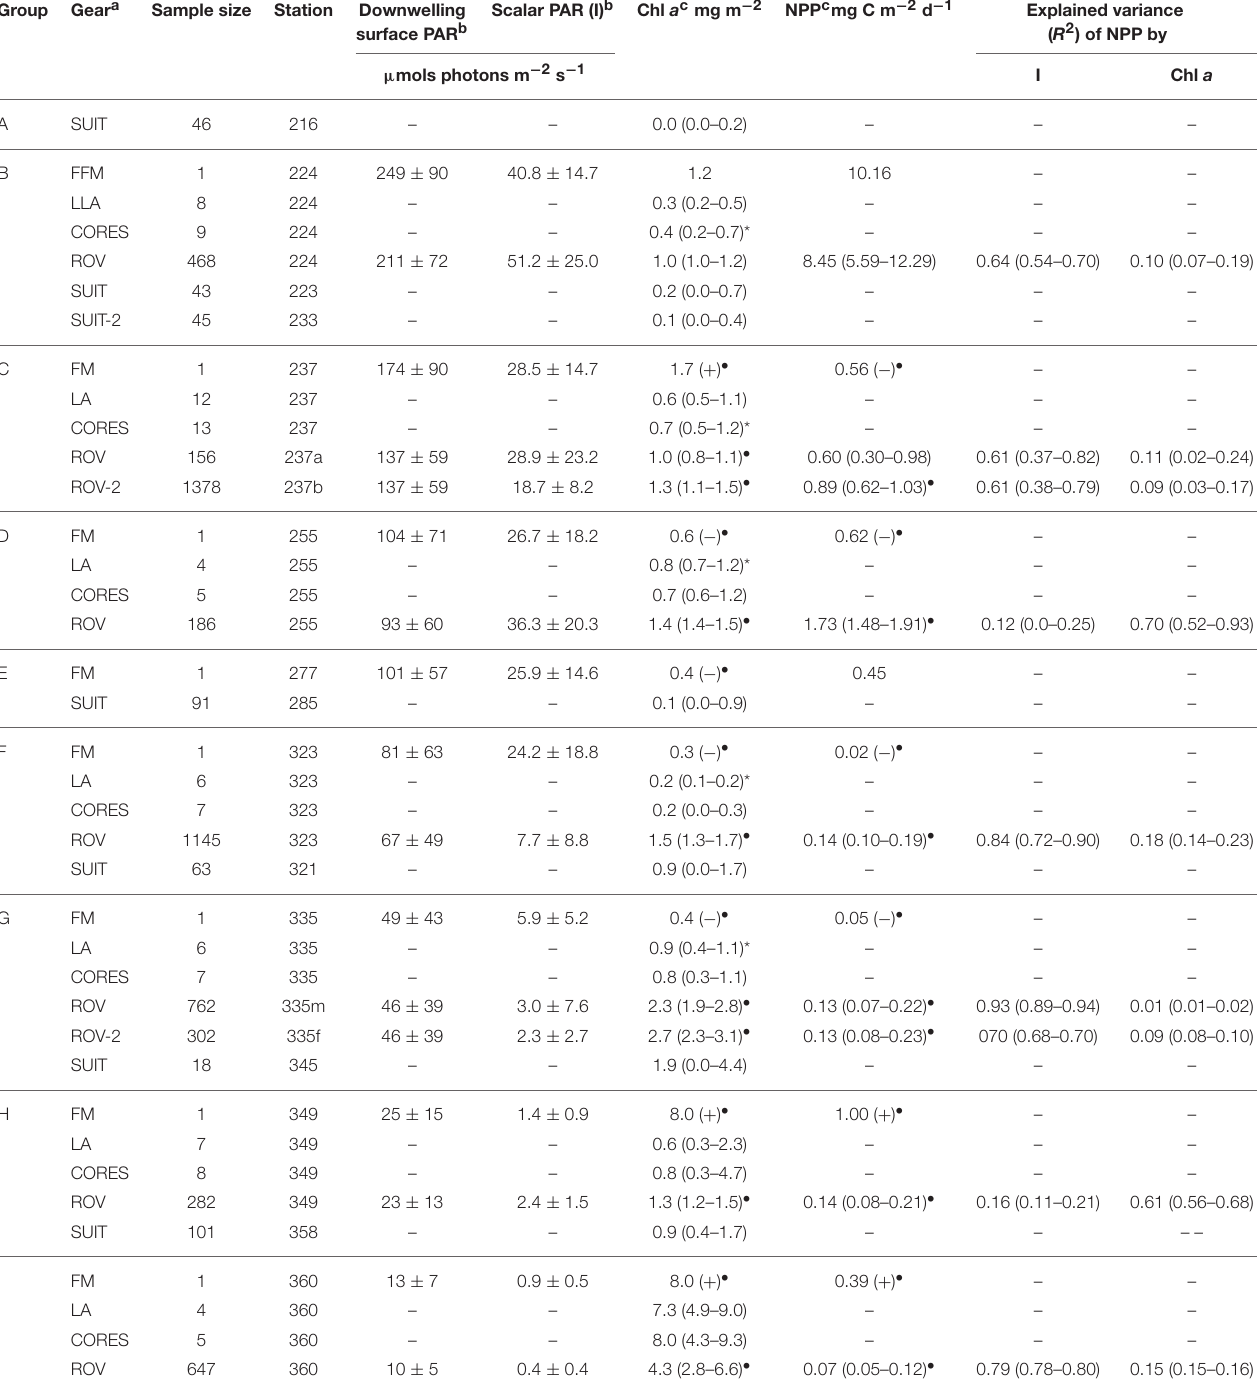
TABLE 1 | Summary of downwelling surface and bottom-ice light, chlorophyll a biomass (chl a ), net primary production (NPP), and explained variance of NPP per location (shown in Figure 1 ) and sampling method (gear): ice cores (FM or LA), remotely operated vehicle (ROV) and surface and under-ice trawl (SUIT). Group Gear